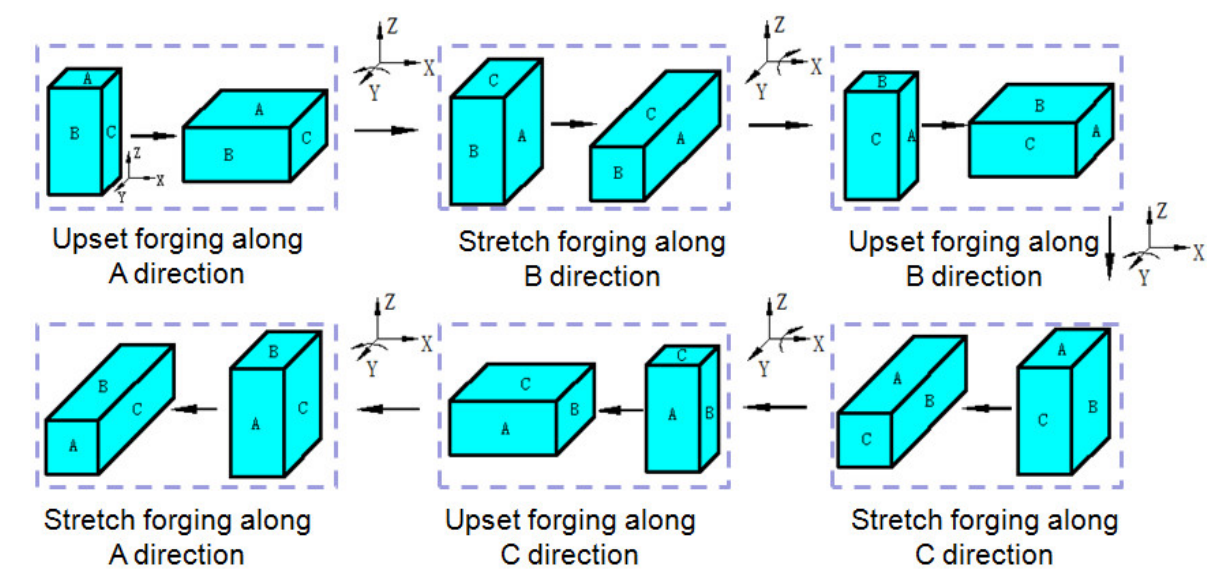
Figure 1. Schematic diagram of multidirectional forging (MDF) process.